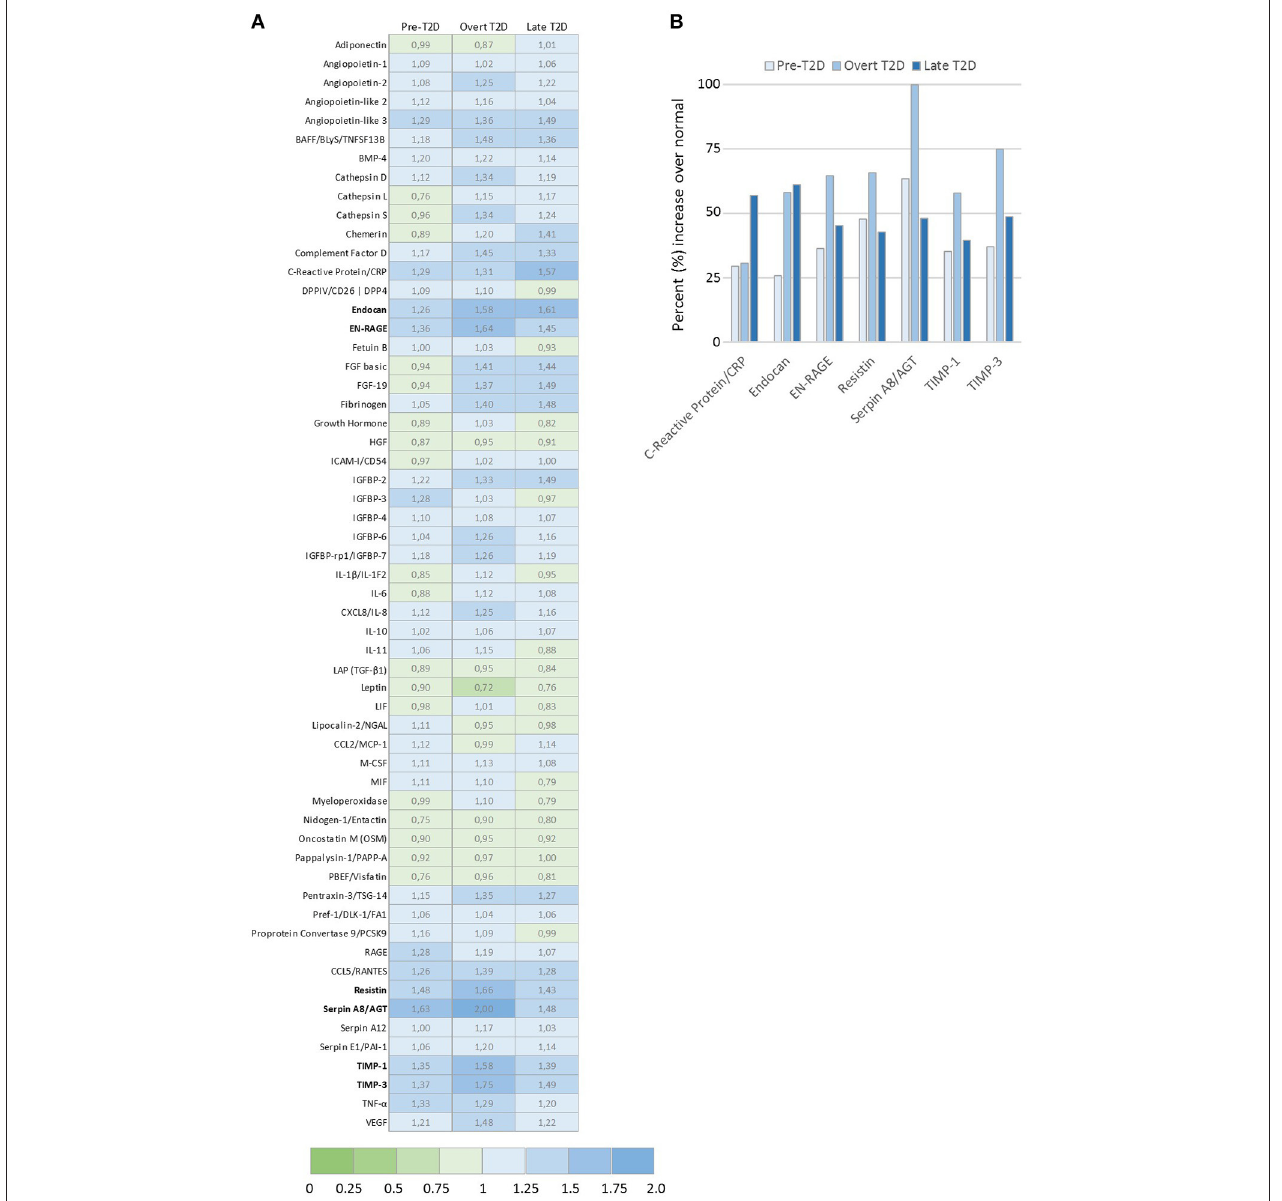
FIGURE 4 | Adipokine proteome profile analysis of relative levels of 58 secreted adipokines by 3T3-L1 adipocytes. (A) Graph shows the top modulated adipokines by 3T3-L1 adipocytes cultured under obesity-associated metabolic conditions Pre-T2D, overt T2D, or late T2D, with ≥ 50% increase relative to normal (low glucose/low insulin) metabolic conditions. (B) Ratio of relative expression levels of the 58 individual adipokines secreted by 3T3-L1 adipocytes cultured under pre-T2D, overt T2D or late T2D metabolic conditions compared with normal. Relative adipokine levels in normal metabolic conditions = 1, increased levels ( > 1.0; blue), decreased levels ( < 1.0; green) compared with